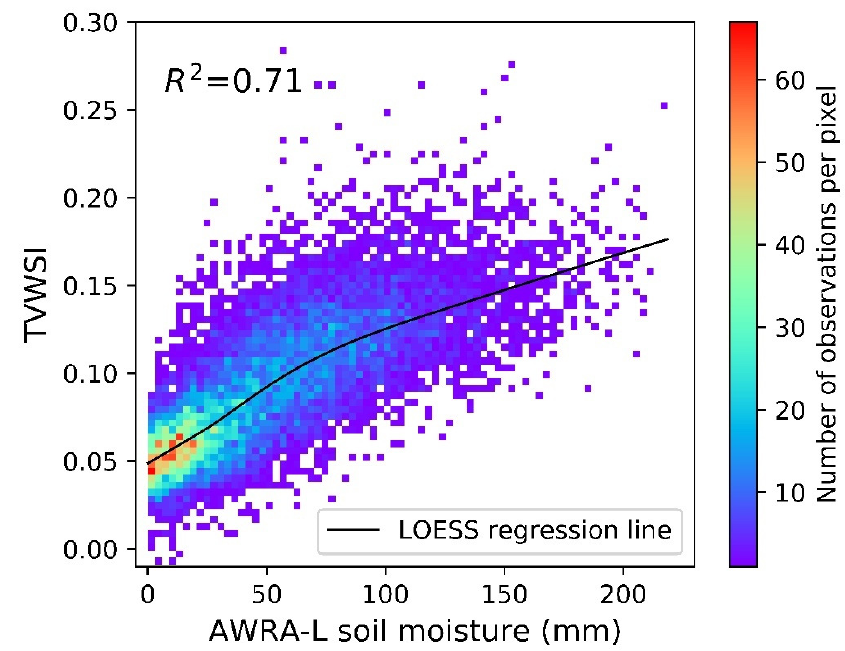
Figure 9. Density scatter plot with the fitted LOESS regression line and R 2 on the weekly observations from sixty study sampling windows: TVWSI vs. AWRA-L soil moisture. The color represents the number of observations per pixel.